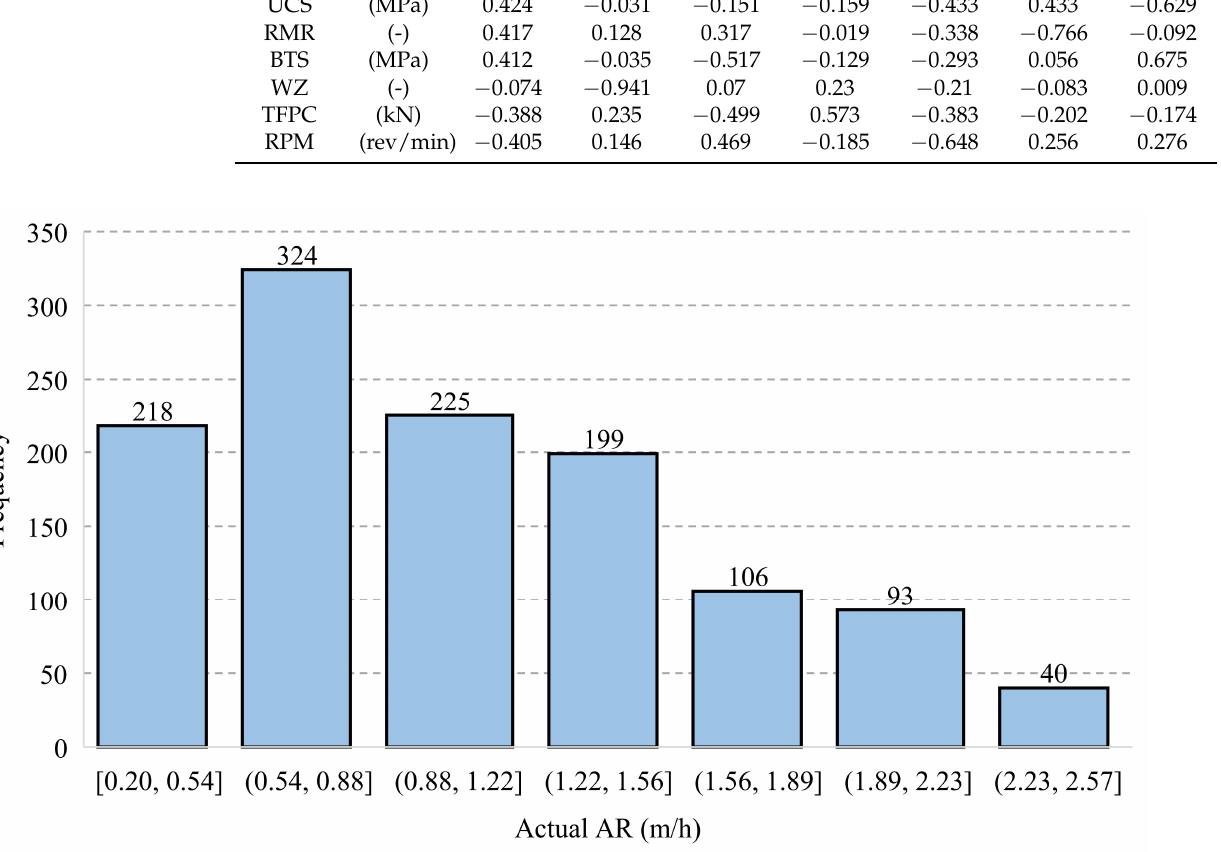
Figure 6. Histogram of the AR parameter.